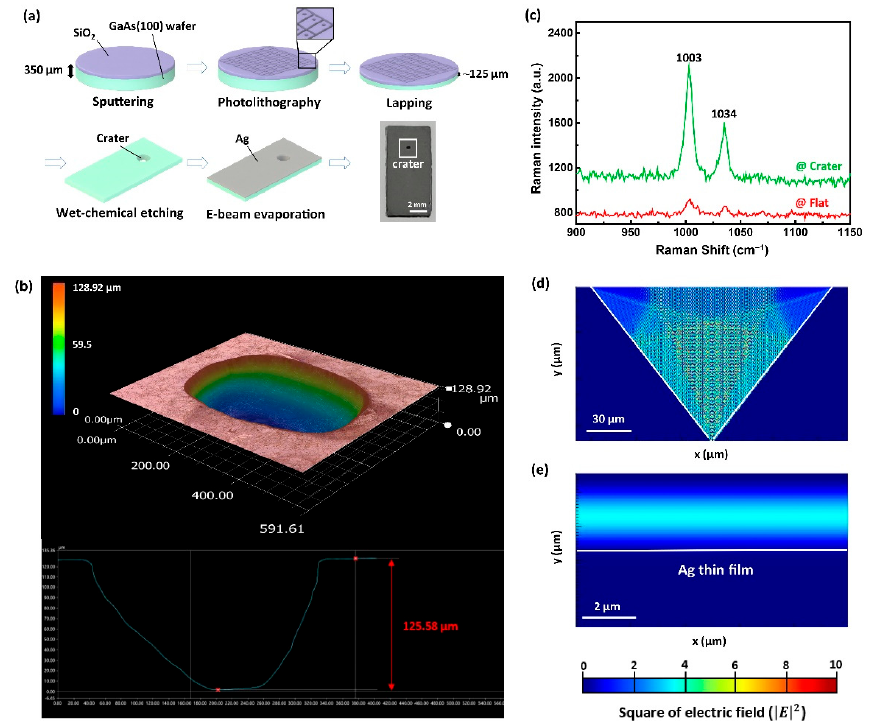
Figure 2. ( a ) Schematic of the fabrication process of the GaAs crater structure with the Ag film. ( b ) Optic microscope image of the crater and depth profile. ( c ) Raman spectra on the crater and flat structure with an exposure time of 20 s and pyridine solution of 0.1 M. FDTD simulation at ( d ) the crater and ( e ) the flat structure.